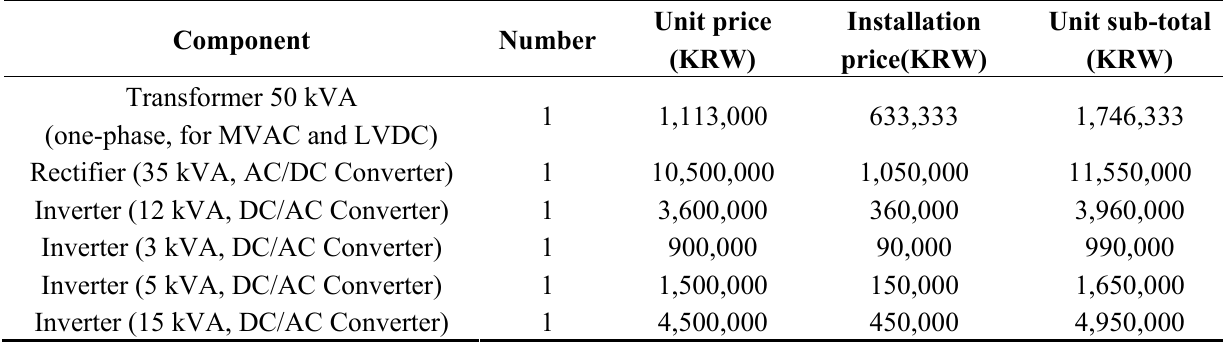
Table 2. Transformer and power converter installation costs. AC: alternative current; and DC: direct